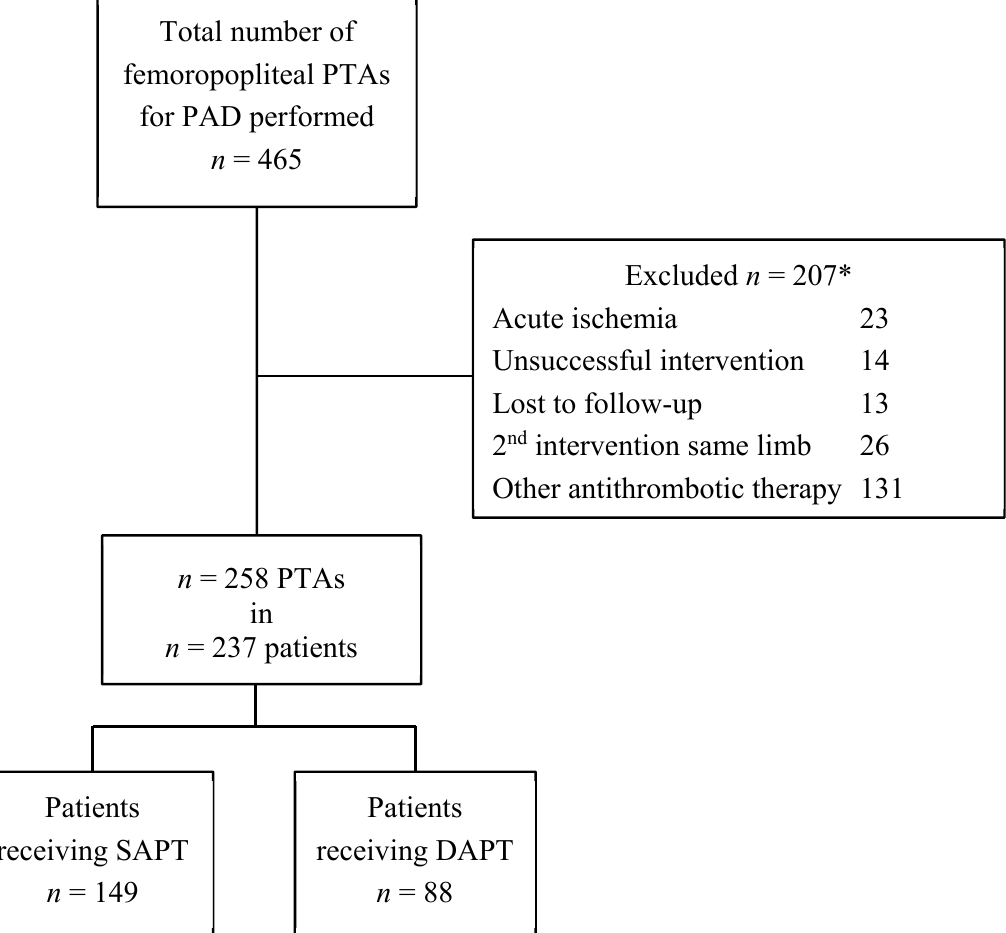
Figure 1. Flowchart of the inclusion process. DAPT = dual antiplatelet therapy; n = number; PAD = peripheral arterial disease; PTA = percutaneous transluminal angioplasty; SAPT = single antiplatelet therapy. * Patients could have more than one reason to be excluded; only one reason was registered.